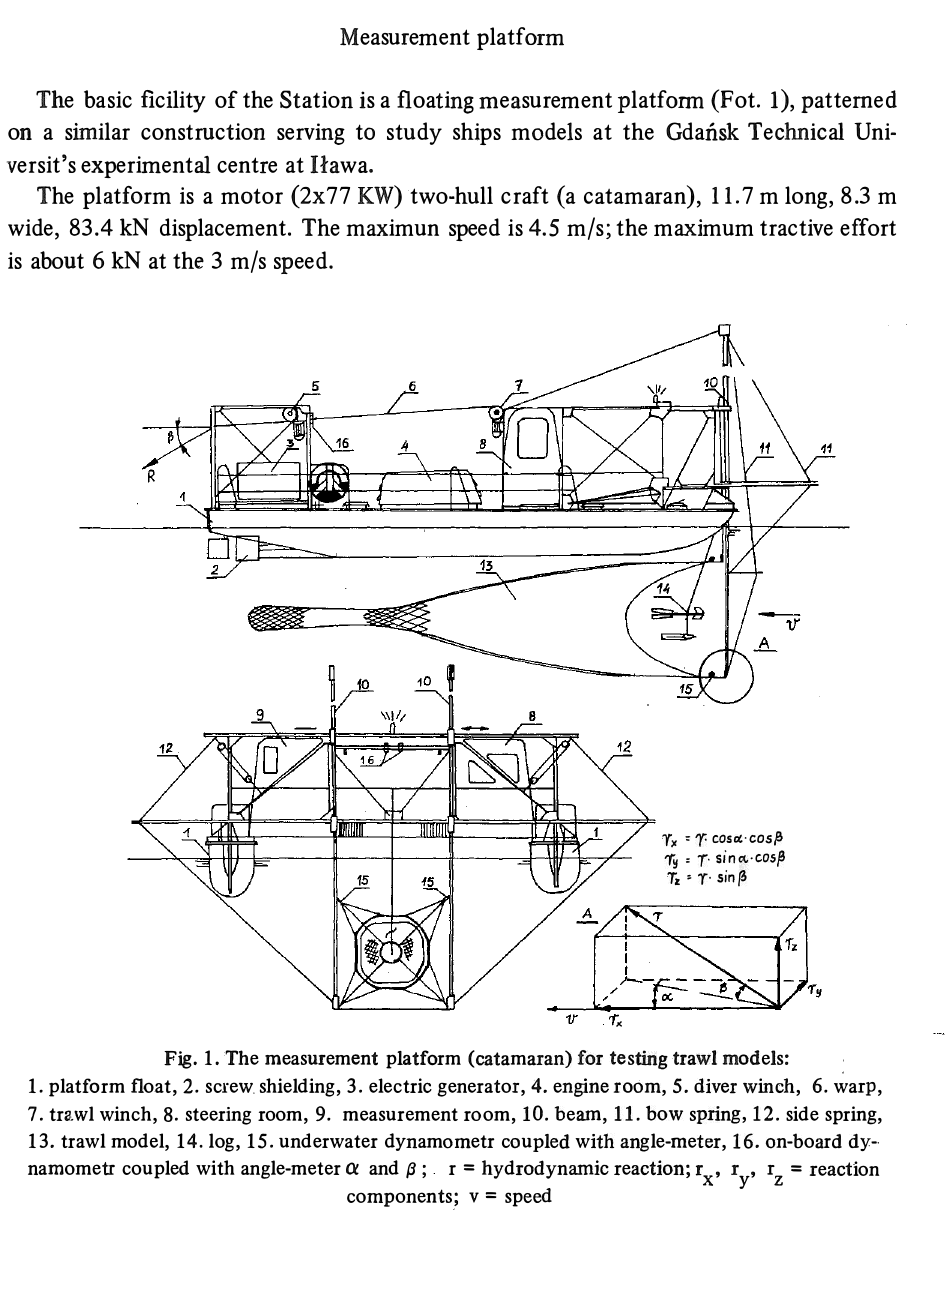
Fig. 1. The measurement platform (catamaran) for testing trawl models: 1.platform float, 2. screw shielding, 3. electric generator, 4. engine room, 5. diver winch, 6. warp, 7.trnwl winch, 8. steering room, 9. measurement room, 10. beam, 11. bow sprjng, 12. side spring, 13.trawl model, 14. log, 15. underwater dynamometr coupled with angle-meter, 16. on-board dy-· namometr coupled with angle-meter OI and /3; r = hydrodynamic reaction; r x, r y, r = reaction z components; v =